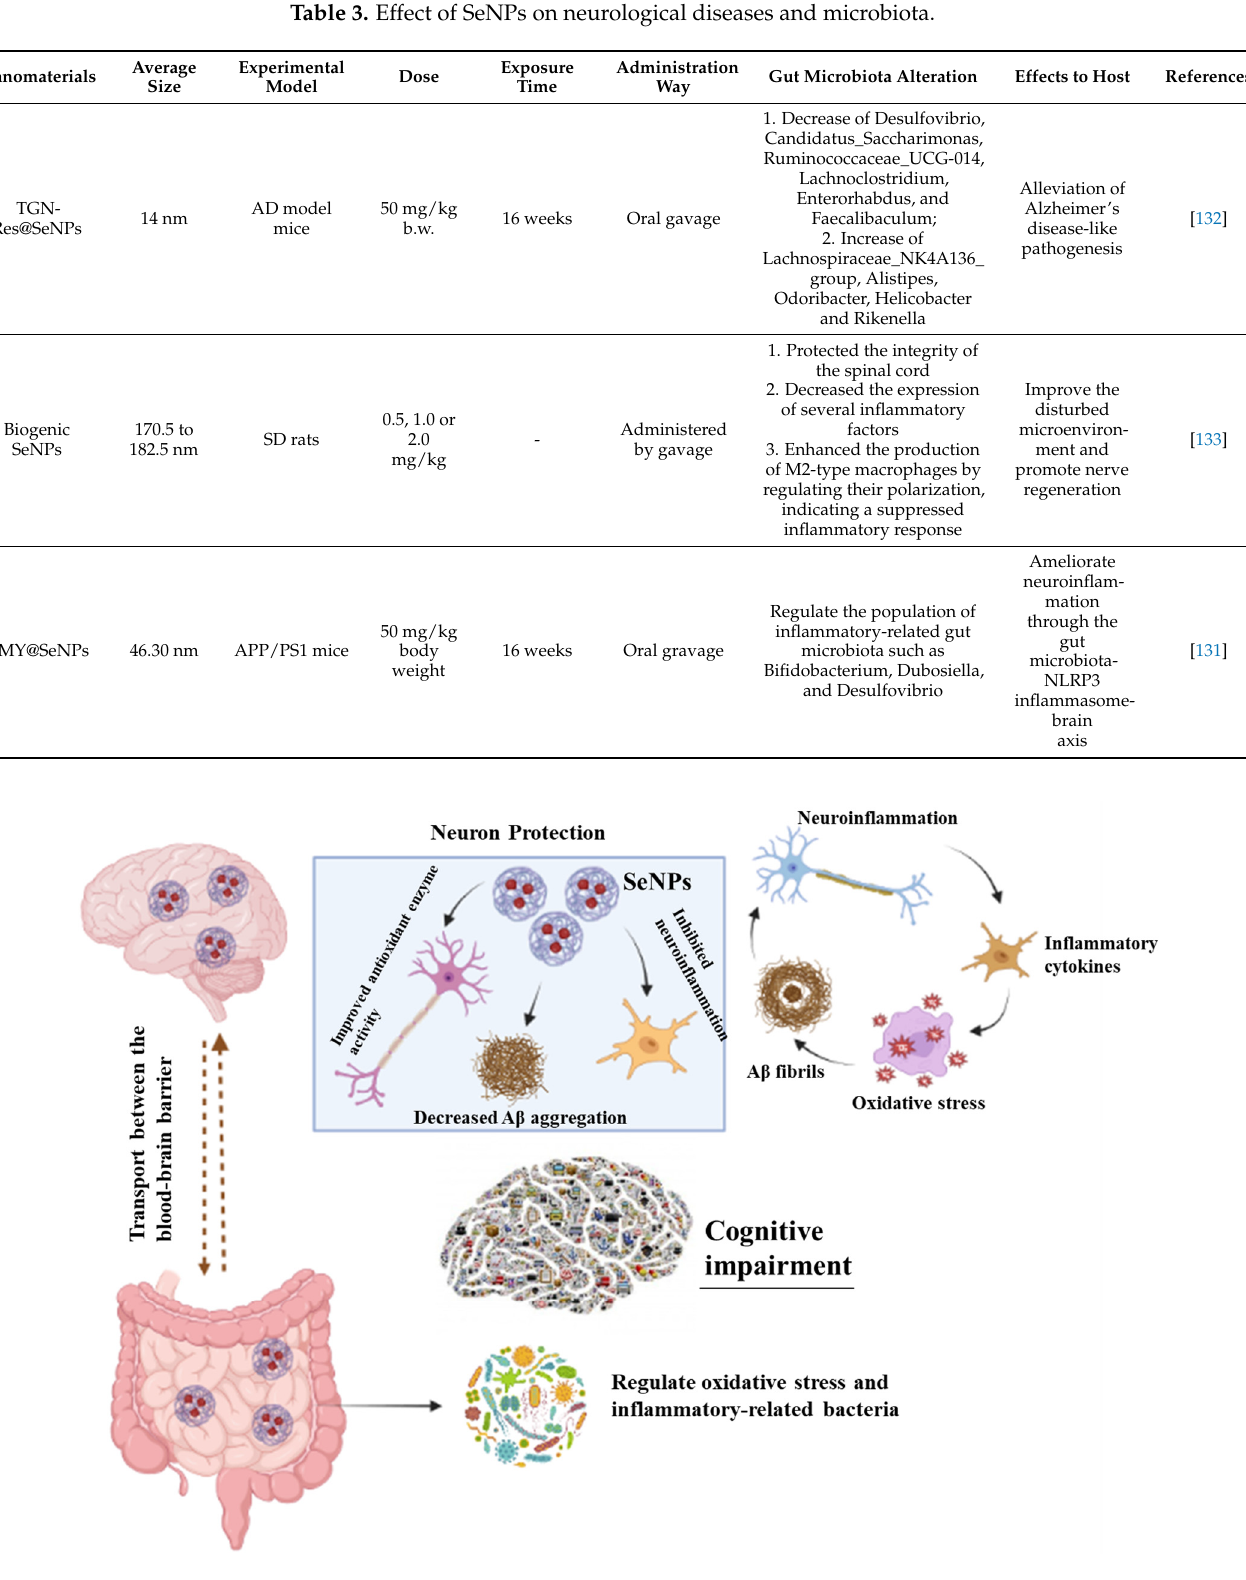
Figure 5. SeNPs’ mechanism of action to diminish Alzheimer’s disease-like pathogenesis.